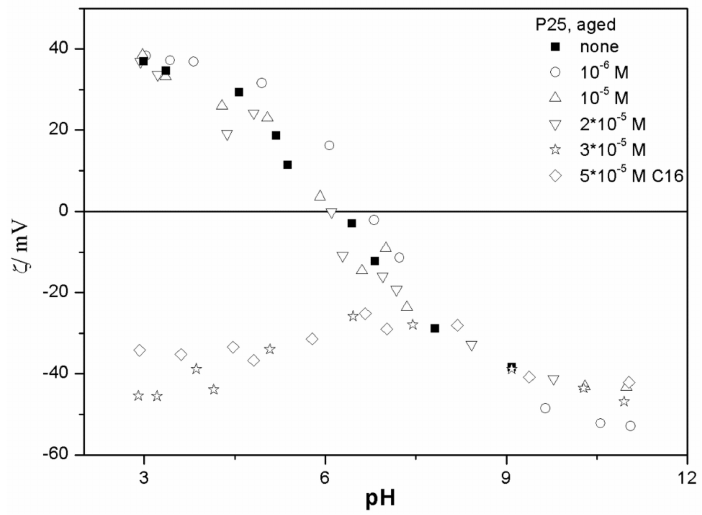
Figure 4. The ζ potential of titania in aged dispersions in the presence of sodium tetradecylsulfate.